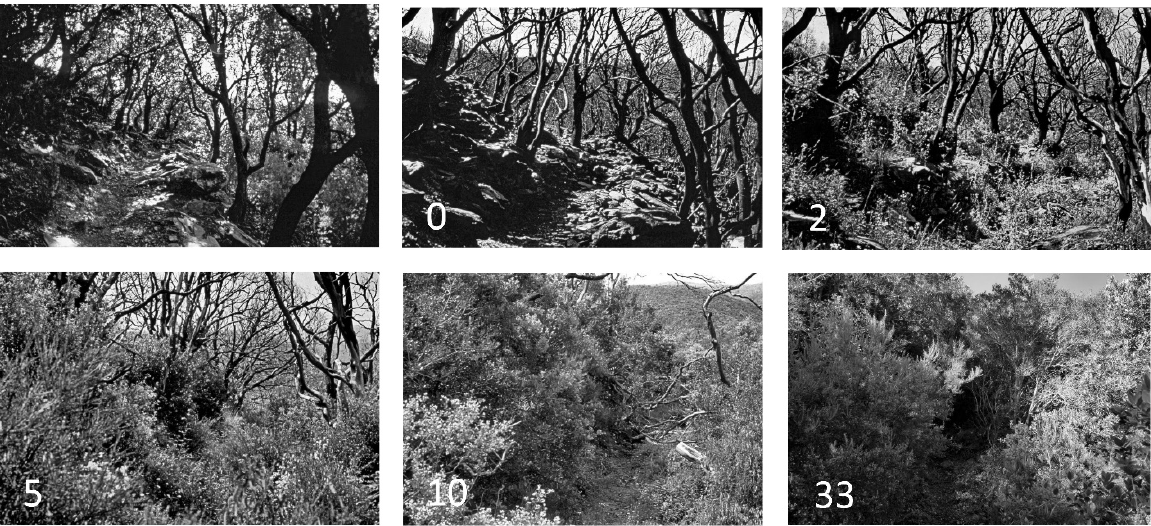
Figure 1. A holm oak stand (class G) before fire ( top left ), immediately after fire ( top middle ) and 2 to 33 years after fire.